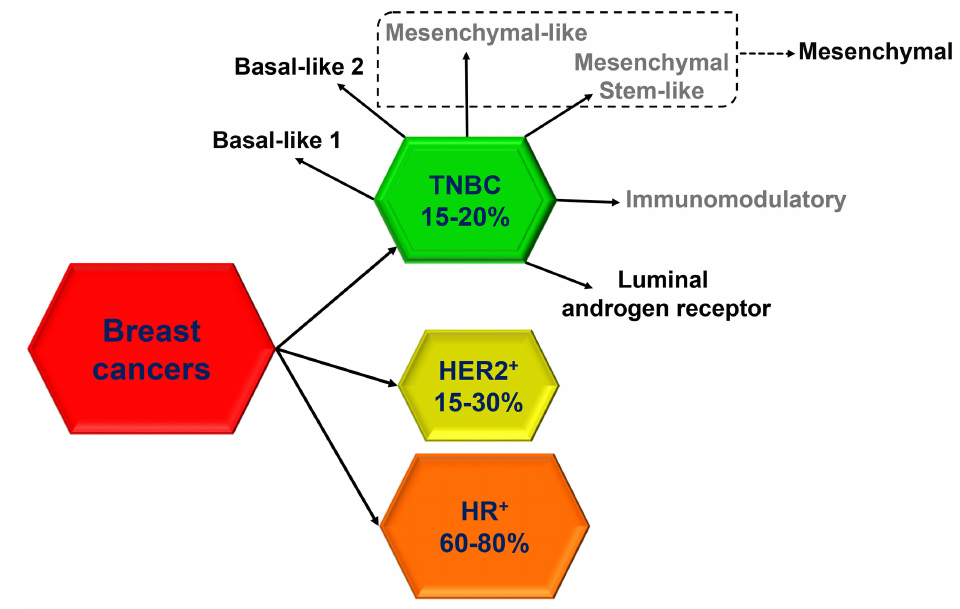
Figure 1. Heterogeneity of TNBC. Six distinct TNBC subtypes were identified by Lehmann et al. [3] including Basal-like 1, Basal-like 2, Mesenchymal-like, Mesenchymal Stem-like, Immunomodulatory and Luminal androgen receptor. This classification was later refined, by the same authors [4], into four subtypes (Basal-like 1, Basal-like 2, Mesenchymal and Luminal androgen receptor). See text for details. The percentage of TNBC [1], HER2-positive [5] and hormone receptor (HR)-positive [6] breast cancers are